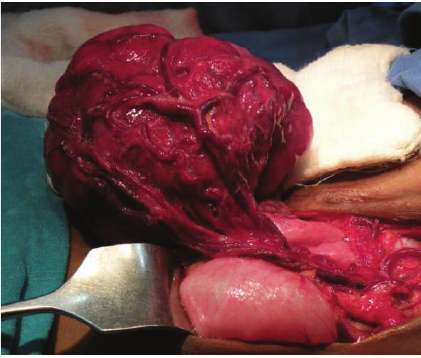
Figure 2: Lobulated mass arising from mesentery of proximal ileum.